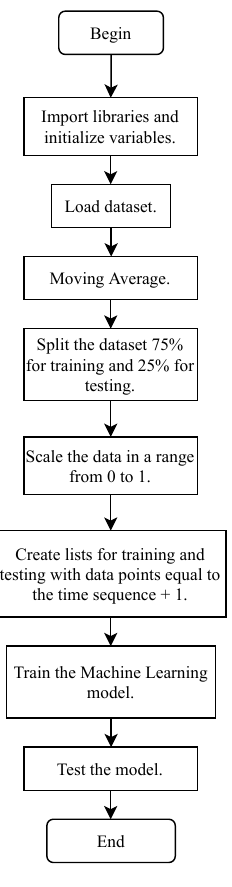
Figure 4. Flowchart of proposed